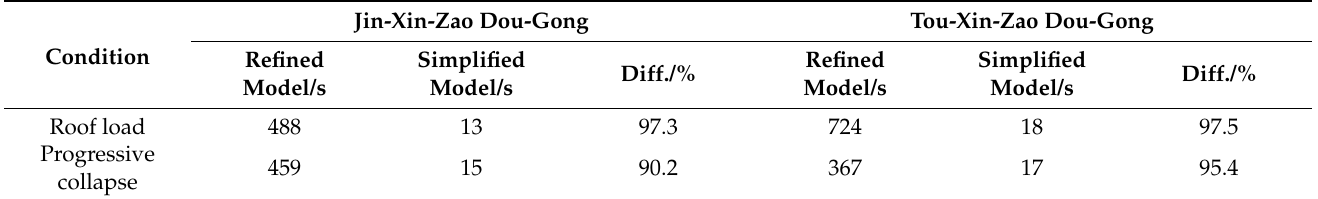
Table 4. Comparison of the time consumptions: refined model vs. simplified model.